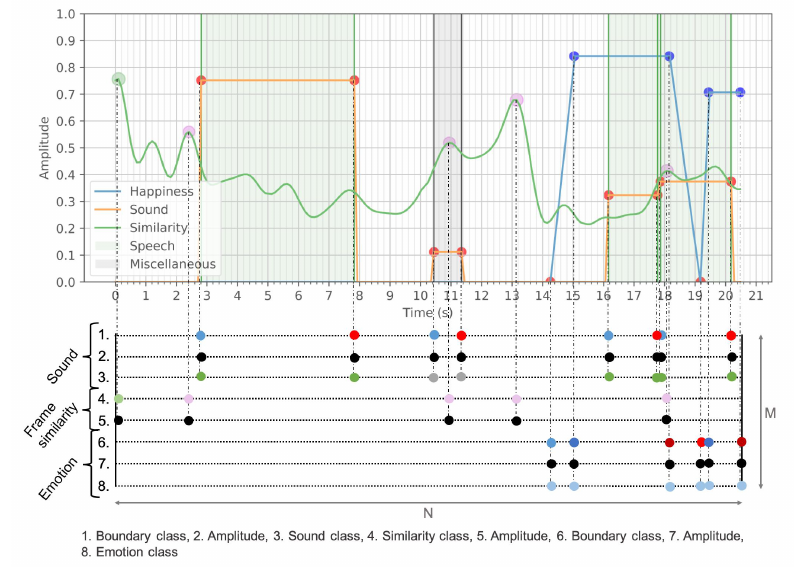
Figure 11. Representation of the events timeline built upon the extracted